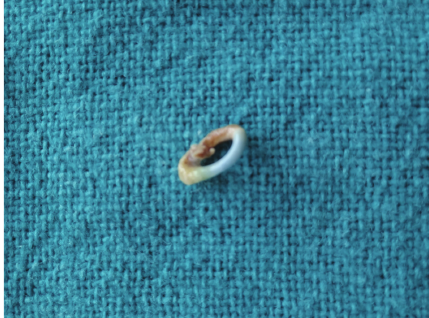
Figure 1: Elastic band protruding through interdental gingiva between right mandibular first and second molars.